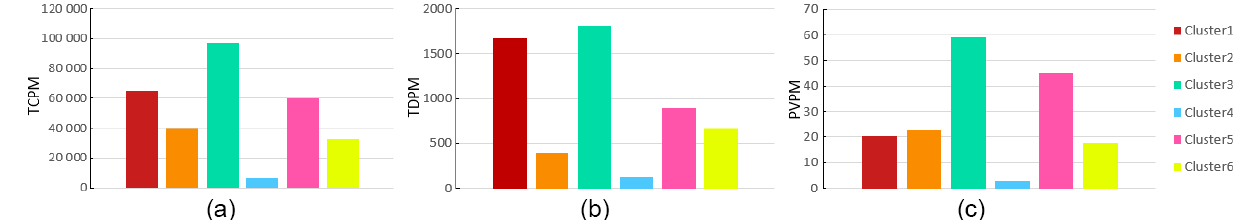
Fig. 11 Bar charts of the mean values of COVID-19 spread or diffusion indicators TCPM, TDPM, and PVPM for each cluster.